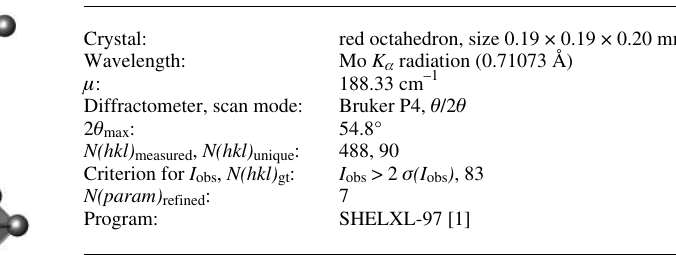
Table 1. Data collection and